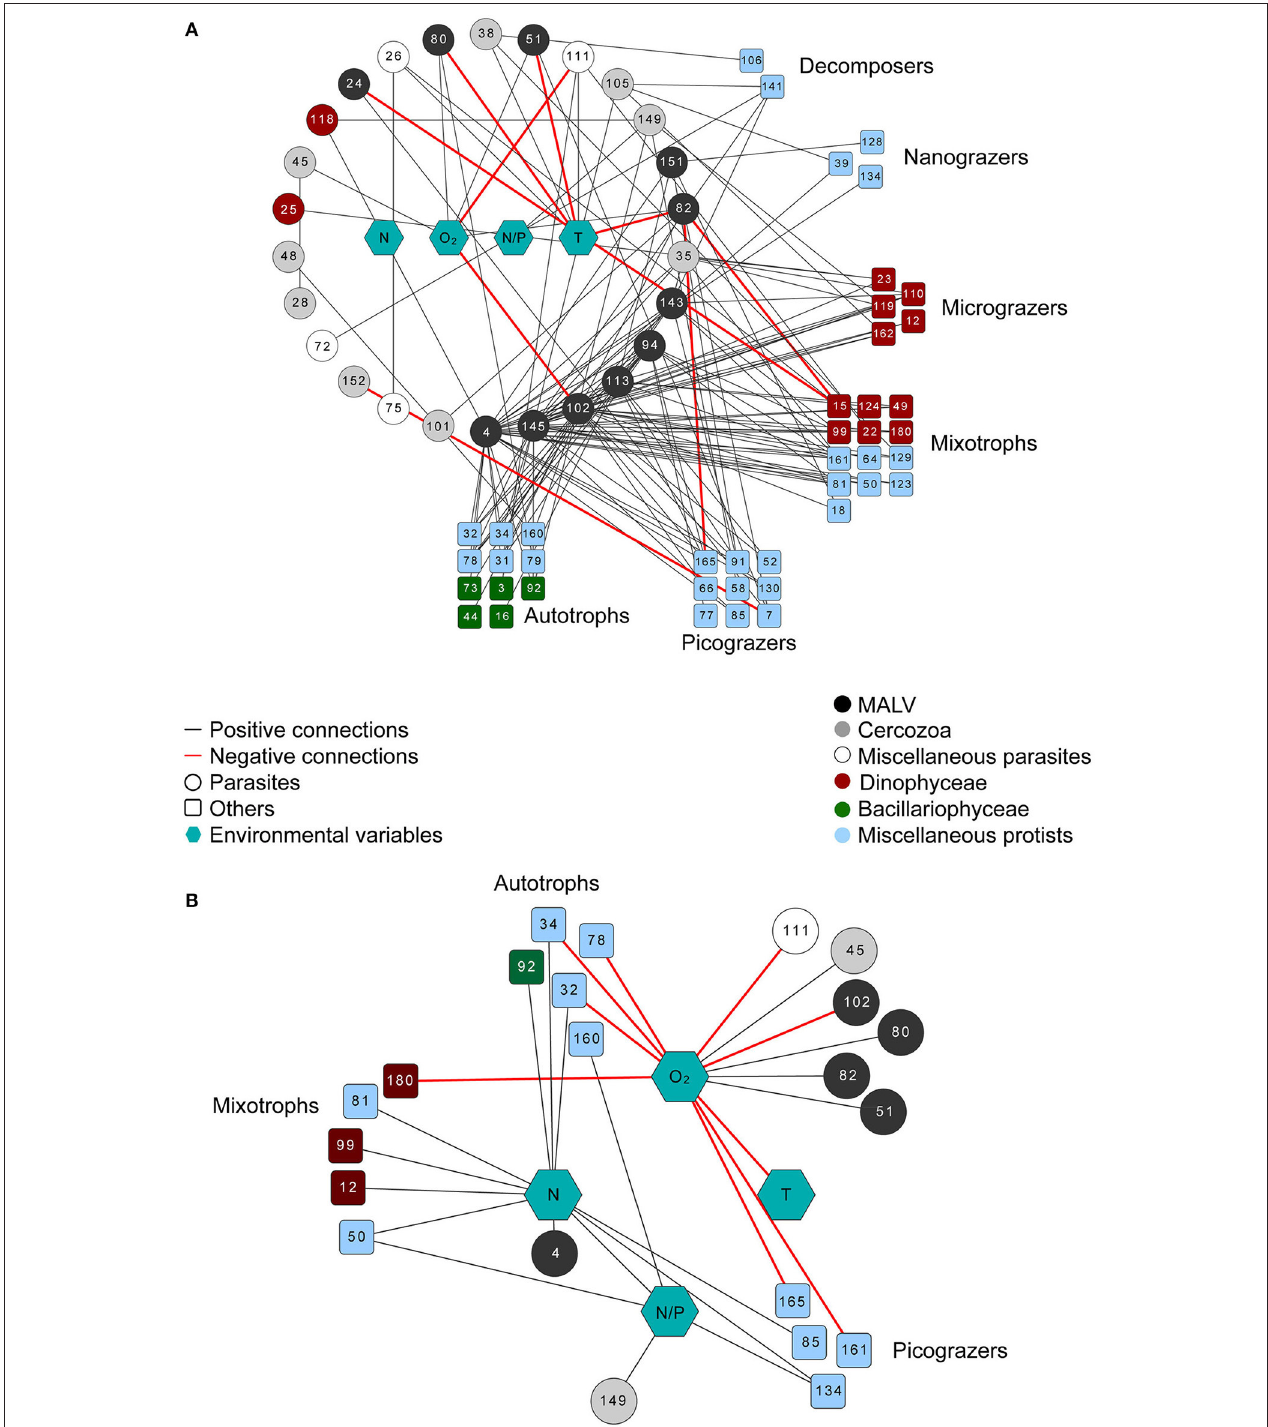
FIGURE 6 | Network diagram of highly significant connections ( R > 0.6 and p < 0.001) between the SymbDec Operational Taxonomic Units (OTUs) and other dominant OTUs, as well as the environmental variables (nodes) as determined by LS analysis (LSA) using a delay of one time point. To facilitate reading all the potentially parasitic nodes are structured as a circle which can be read anticlockwise starting from the OTU4, which has the maximum number of connections (A) ; Network diagram of highly significant connections ( R > 0.6 and p < 0.001) between environmental parameters and dominant OTUs (nodes) as determined by LS analysis using a delay of one time point (B) . The exagons represent the environmental variables, the circles represent parasitic taxa, and the rectangles all other taxa. Different colors: different taxonomic groups with emphasis on Dinophyceae (red) and Bacillariophyceae (green). Black lines (edges) represent positive connections and red lines represent negative connections. See also Table 3 for taxonomic details of the OTUs presented on this figure.